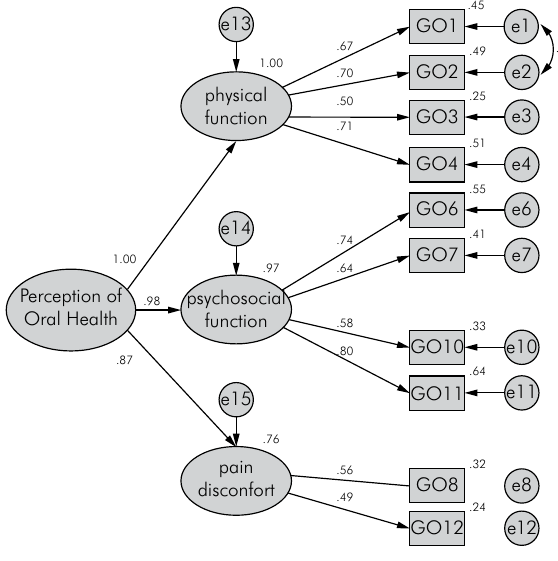
Figure 1. Second-order hierarchical model adjus- ted to the total sample ( χ 2 /df = 3.66, CFI = 0.97, GFI = 0.97, RMSEA = 0.06) for the